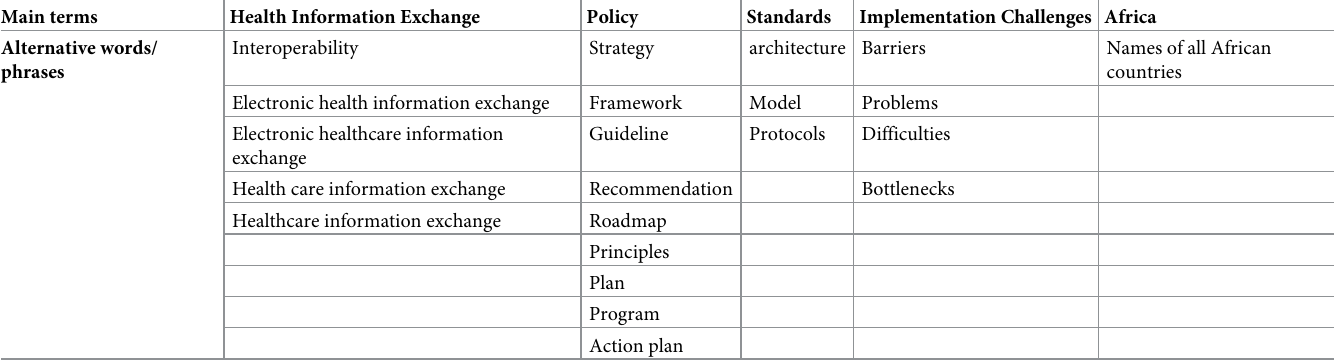
Table 1. Search terms of Health information Exchange Policy, Standards, or implementation challenges in